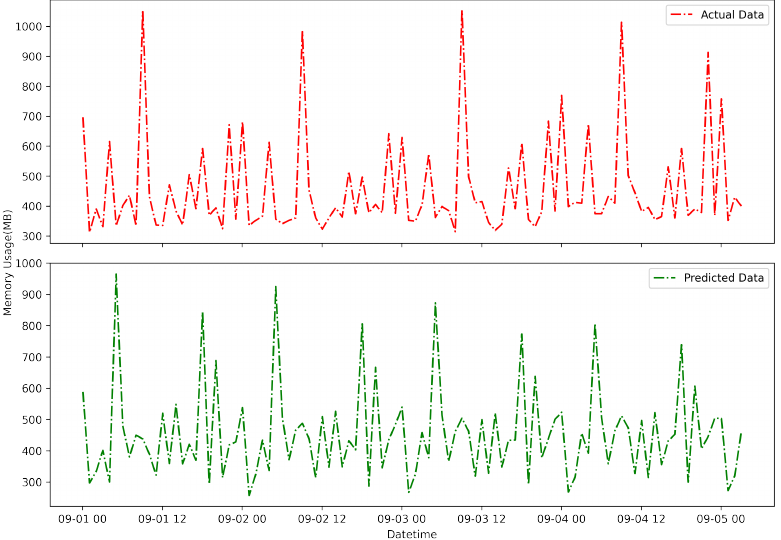
Figure 8. Behaviour of actual memory usage and prediction